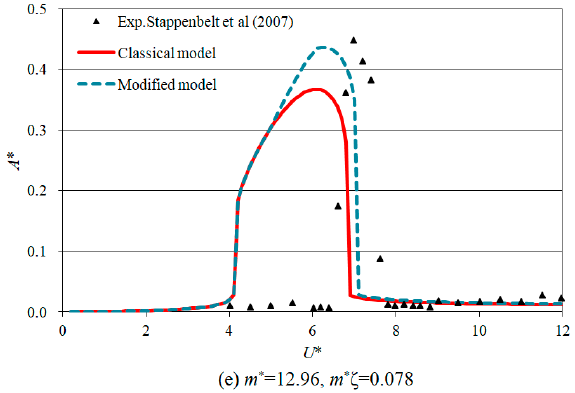
Figure 5. Responses of the maximum amplitude versus reduced velocity with different m * and ζ ( m * = 0.52~12.96, m * ζ = 0.0027~0.078) [14].